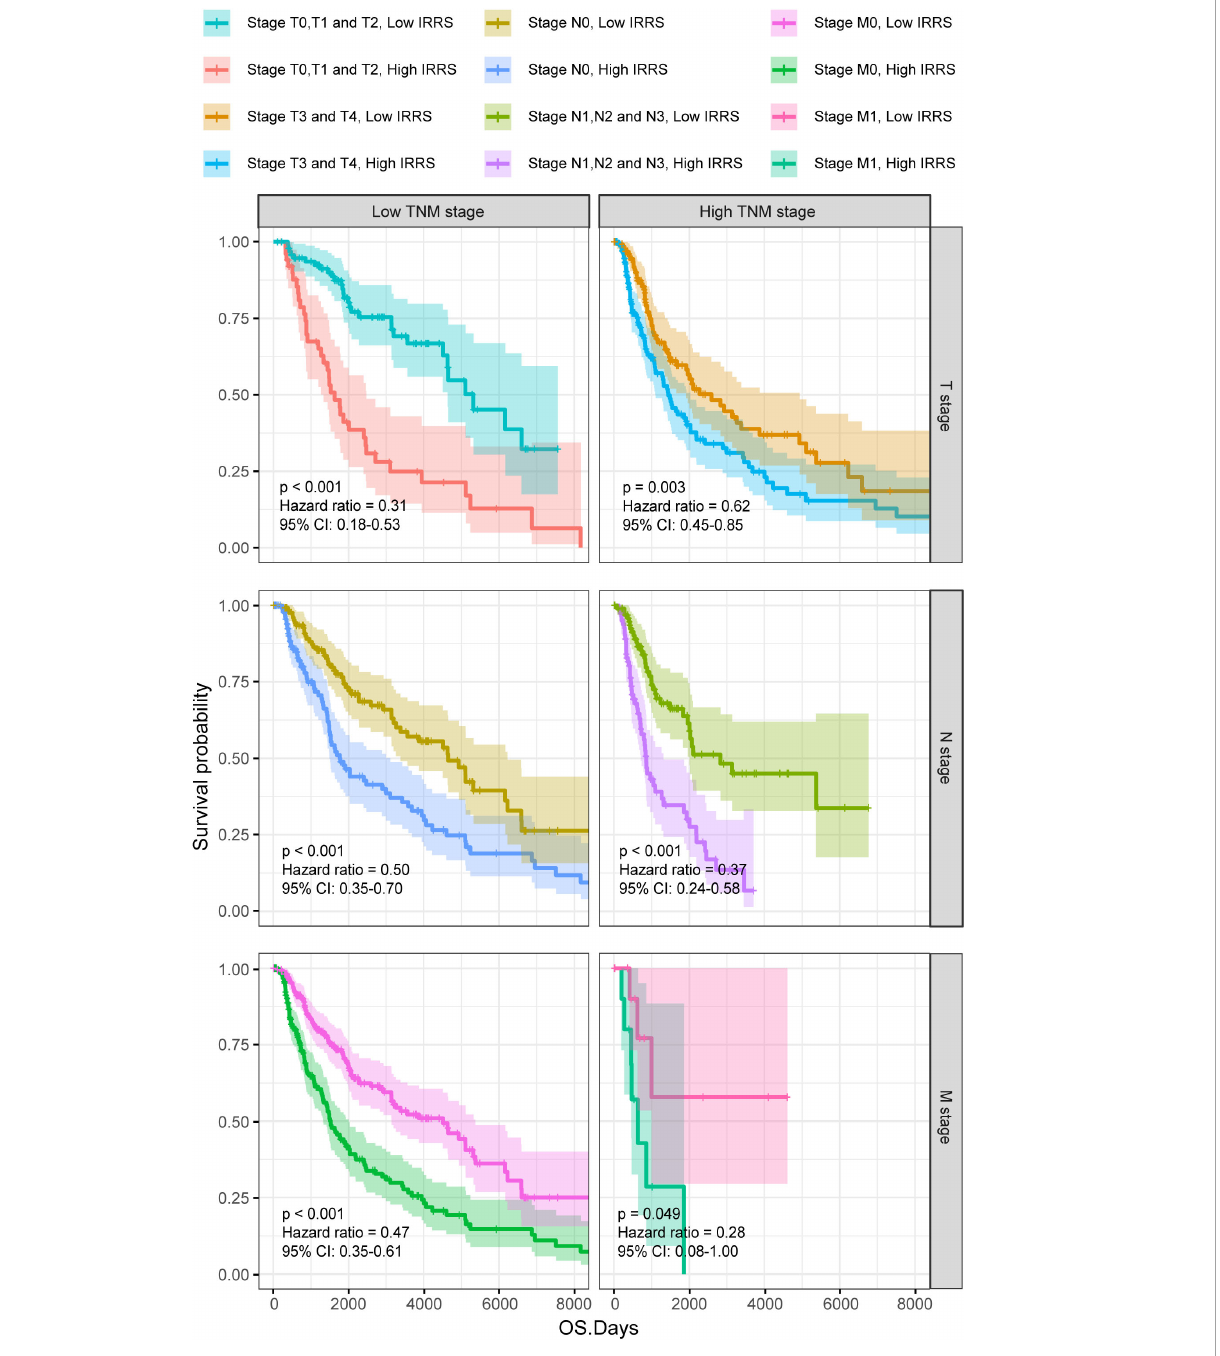
FIGURE 3 The Kaplan – Meier survival curves according to different TNM stages of patients from the TCGA-SKCM classi fi ed into high- and low-risk groups based on the IRRS